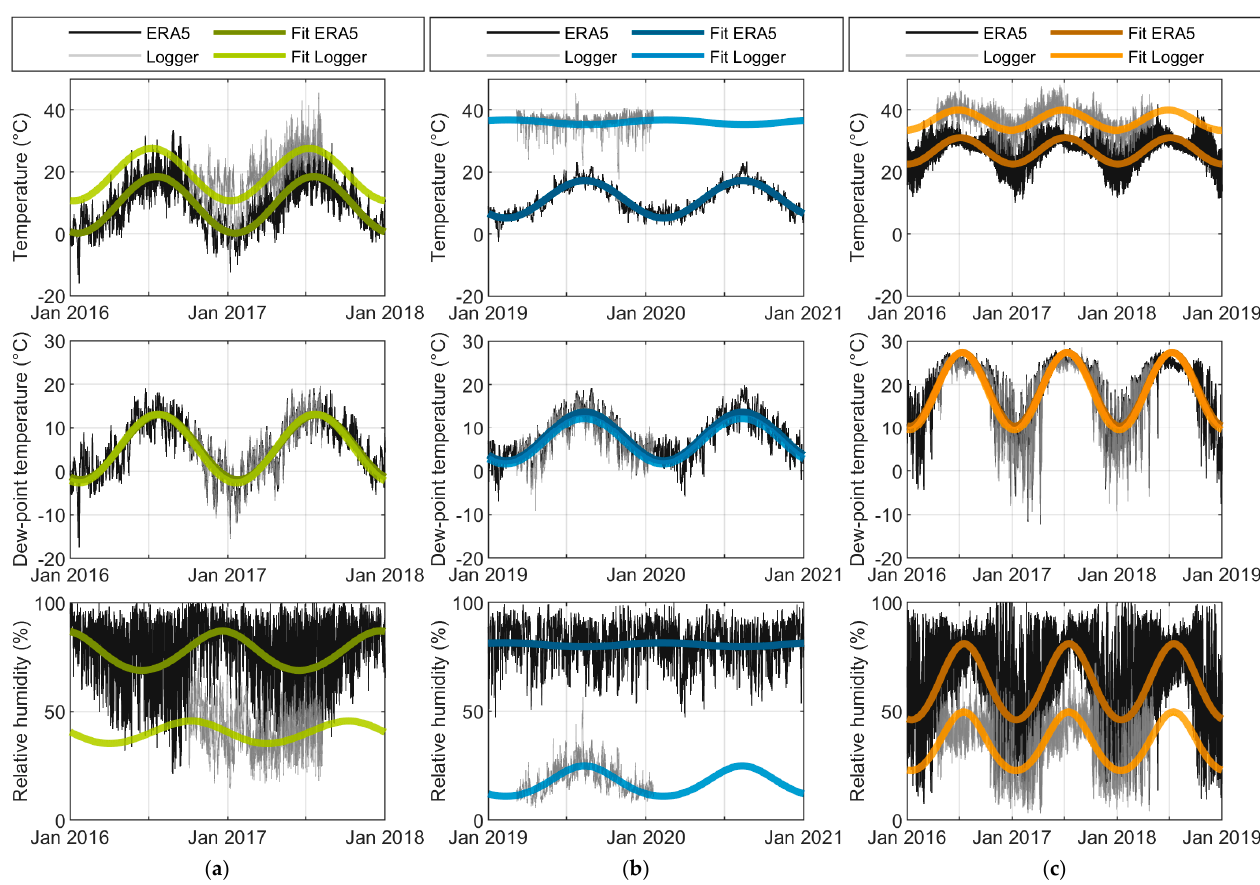
Figure 15. Sinusoidal fit functions for the temperature and dew-point temperature and resulting relative-humidity time series inside the converter cabinet (“Logger”) and in the WT environment (“ERA5”) for the three wind turbines WT1 ( a ), WT2 ( b ) and WT3 ( c ).